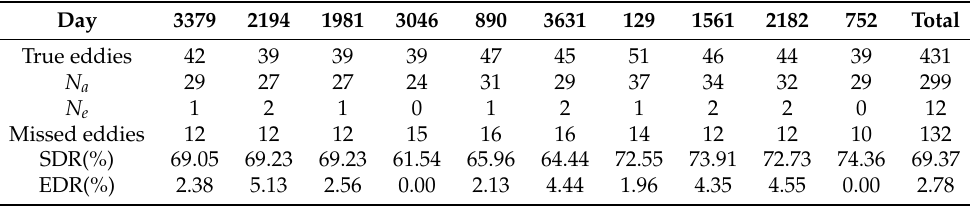
Figure 5. Comparison between true eddies (green dots) and algorithm-detected eddies (green circles) for day 2182 (21 December 2016). The left panel shows the multi-model detection results. The right panel shows the VG algorithm’s detection results. Table 2. CMM results for the 10 days used for the validation: True eddies are the eddies identified via manual detection; Na is the number of true eddies detected by the automated method; Ne is the number of eddy centers detected by the algorithm that do not correspond to a true eddy. SDR and EDR are defined in Equations (1) and